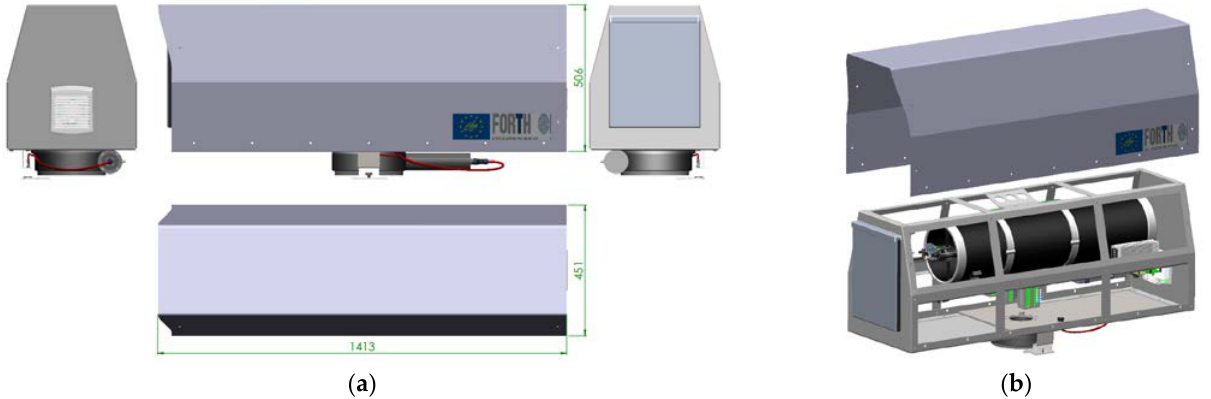
Figure 2. CAD images of the instrument’s ( a ) external and ( b ) internal configuration (dimensions in mm).